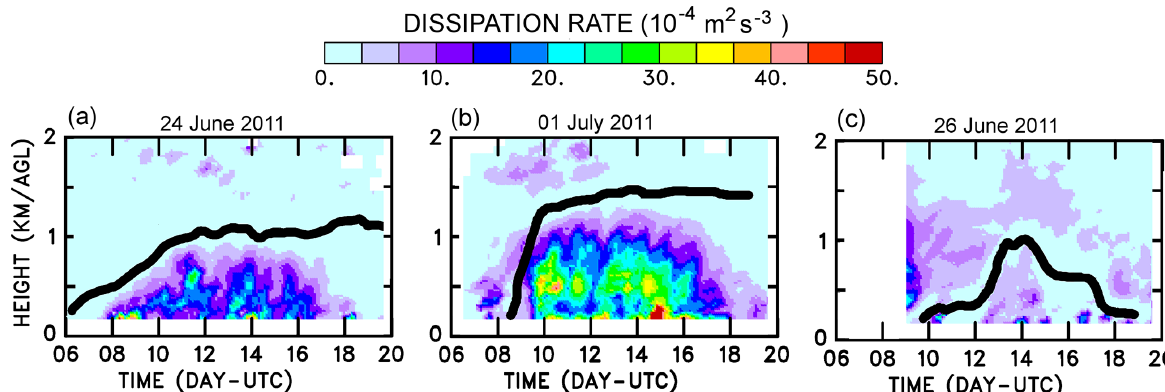
Figure 10. Time-height section of TKE dissipation rate estimated from UHF wind profiler during (a) 24 June, (b) 1 July and (c) 26 June 2011. The evolution of the CBL top inversion (deduced from local maximum of the refractive index structure parameter) is indicated by the black thick line.